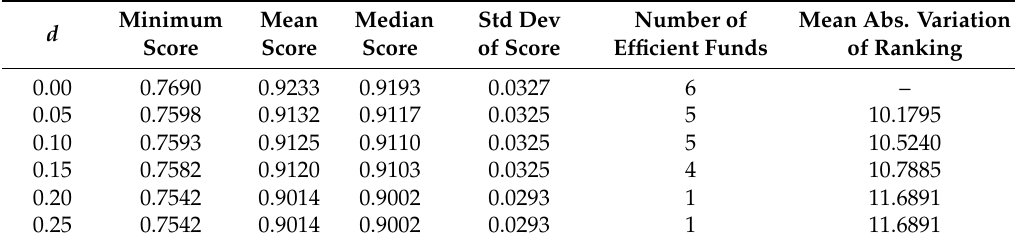
Table 2. Main results for the virtual weights (VW) restrictions with constraints on all decision-making units (DMUs) in the case of symmetric bounds and T = 1. Summary statistics on the performance scores (minimum, mean and median values, standard deviation), number of efficient funds and mean absolute variation (divided by 2) of the ranking positions.